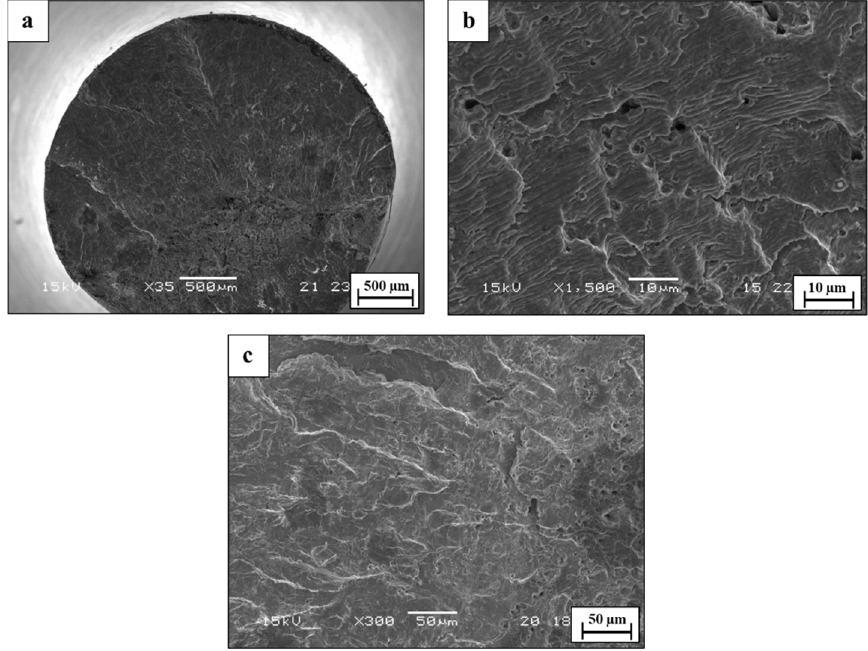
Figure 14. Fractography analysis of counterpart AISI 316L alloy in 3.5% NaCl solution (S = 300 MPa, N = 5,900,000). ( a ) General view ( b , c ) close-up view. The fractography analysis of the WLAM 316L alloy in air demonstrated a relatively brittle fracture with a complex appearance that is related to the inherent macrostructure